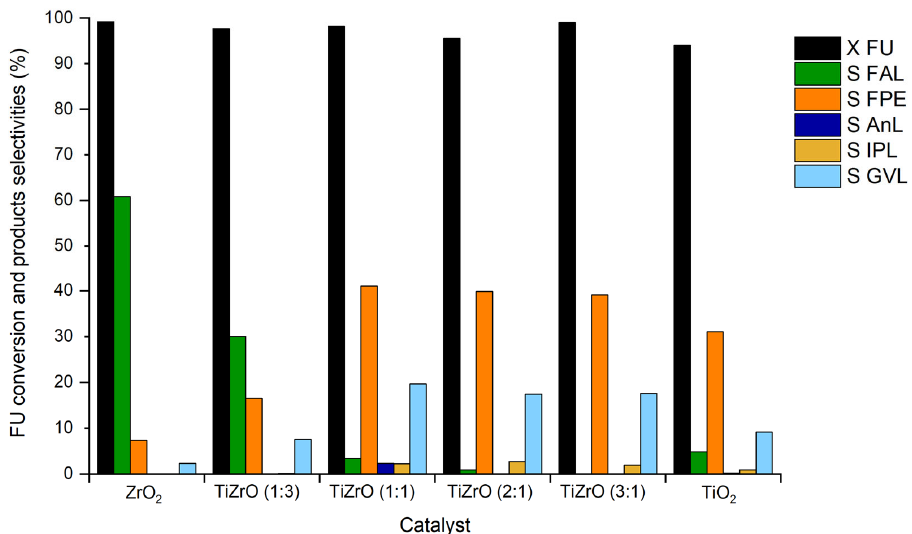
Figure 8. Catalyst performance comparison for the one-pot reaction from furfural to γ -valerolactone. Reaction conditions: [FU] = 67 mM, τ = 10 min, T = 180 °C, m cat between 0.76 and 0.94